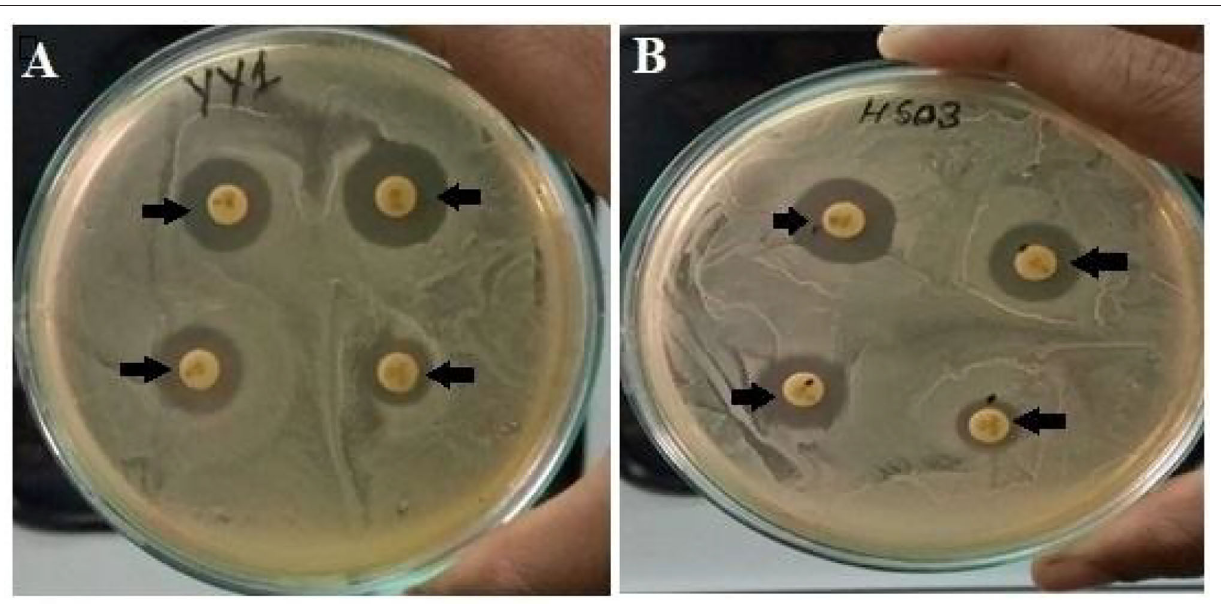
Similarly, feed intake was higher in the HCD group (208.2